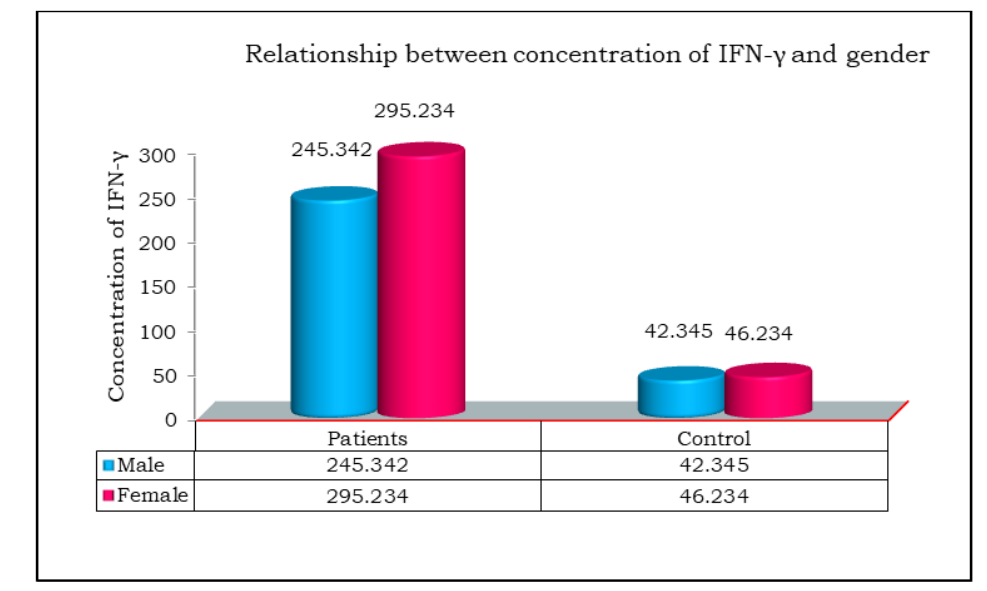
Fig. 8. The levels of IFN-γ (pg / ml) concentration according to patients with pneumonia and control sex groups